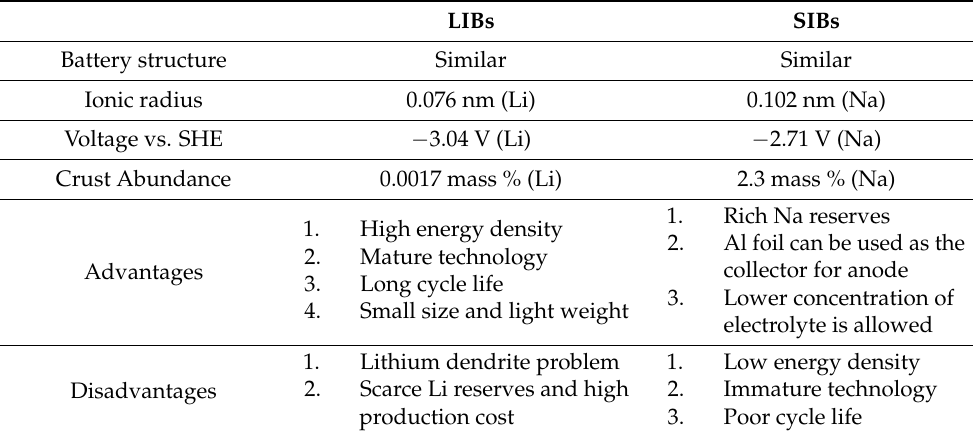
Table 1. Characteristics, advantages and disadvantages of LIBs and